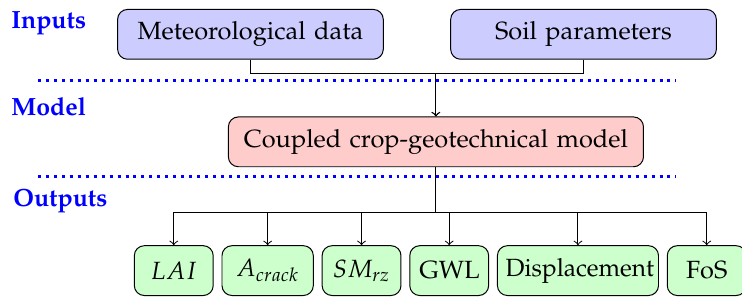
Figure 1. Flow chart of numerical modelling procedure